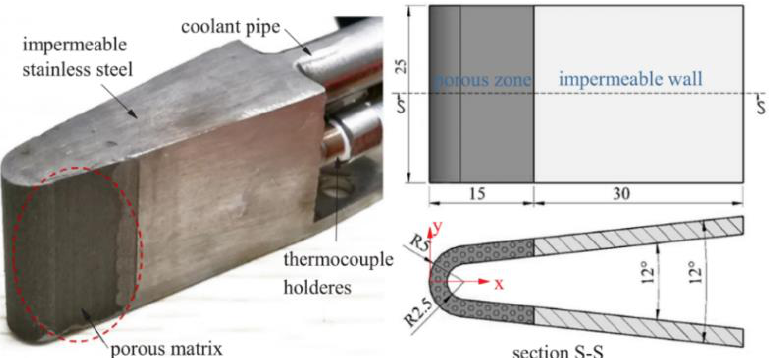
Figure 9. Illustration of transpiration cooling of a whole C3X blade. ( a ) dimensions of the exterior, ( b ) a typical internal cooling channel, ( c ) effusion cooling surface and ( d ) transpiration cooling surface. Reprinted/adapted with permission from Ref. [120] . 2020, Elsevier Ltd.